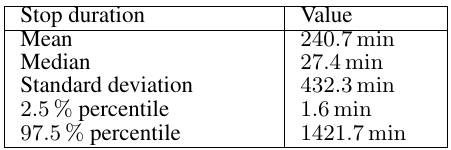
Table 1. Statistical details of all stop durations.